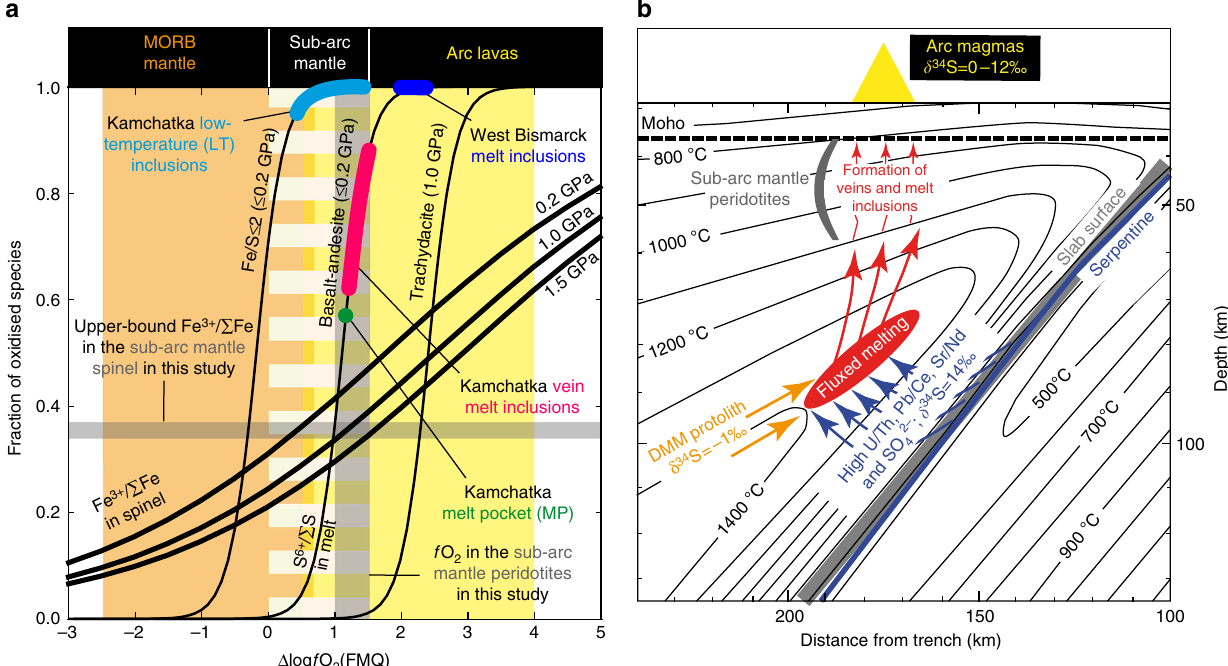
Fig. 1 Sulfur valence state at oxygen fugacities prevailing at mid-ocean ridges and subduction zones and the origins of the glass (formerly melt) inclusions (MI) in Kamchatka and West Bismarck sub-arc mantle peridotites. a S 6 + / ∑ S equilibrium (thin black curves) in silicate melts and the range of Δ log f O 2 measured for subduction zone rocks and melts expressed relative to FMQ: orange, abyssal peridotites (MORB mantle) 43,44 ; white bars, sub-arc mantle rocks 12,13,34 ; yellow, arc lavas 7,8,11 . The S 6 + / ∑ S equilibrium curves are shown for Fe-poor (Fe/S ≤ 2) and Fe-rich (Fe/S»2) silicate melts at low-pressure ( ≤ 0.2 GPa) conditions 8,16 and for 1 GPa 40 . The S 6 + / ∑ S determined by XANES and inferred from Raman spectrometry for Kamchatka LT inclusions, MP, and vein MI and West Bismarck MI are respectively shown in cyan, green, pink and blue. The upper-bound Fe 3 + / ∑ Fe in spinel measured by EPMA (i.e., in halos next to the inclusions) for the percolated harzburgite samples Av33 (Kamchatka) and 67-02D(7) (West Bismarck) is indicated with a grey horizontal bar (Supplementary Tables 5 and 6). The range of Δ log f O 2 calculated for the percolated harzburgite samples Av33 and 67-02D(7), using the EPMA data on spinel (away from the inclusions and their halos) reported in this study and earlier 26,34 , is indicated with a grey vertical bar (Supplementary Tables 9 and 10). Also shown are the calculated Fe 3 + / ∑ Fe in spinel in equilibrium with the parental melts of LT inclusions and MP at 0.2, 1 and 1.5 GPa (bold black curves), using the Fe 3 + / ∑ Fe equilibrium in silicate melts 3 and partitioning coef fi cients for Fe 3 + and Fe 2 + between Cr-bearing spinel and melt 32 (Supplementary Table 12). b A subduction zone cross-section showing the original position of the studied peridotite xenoliths ( ‘ sub-arc mantle peridotites ’ ) from Kamchatka and West Bismarck in the shallow mantle lithosphere before their ascent in arc magmas. Also indicated are the stability fi elds for subducted serpentine (antigorite, dark blue line) 50 and the geochemical features of the inferred fl uids derived therefrom (dark blue arrows) 15,50 , DMM (orange) 48,49 and erupted arc magmas (yellow triangle) 19 – 21,51 . The inclusions in this study allow probing the redox conditions in and sulfur isotope compositions of the deep mantle wedge ( ‘ fl uxed melting ’ , red fi